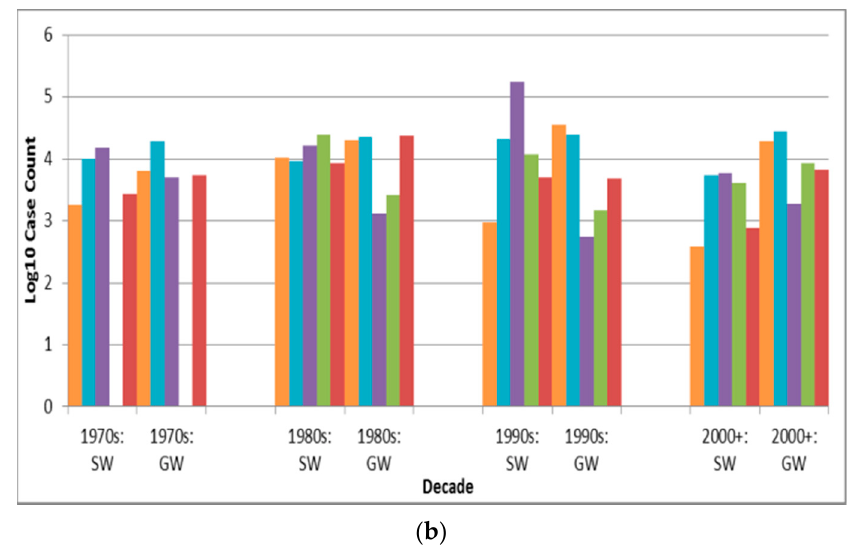
Figure 4. Treatment type outbreak frequency for all recorded decades ( a ) and log 10 decadal case count for 1970s–2000+; ( b ) by source type (SW is surface water, GW is groundwater).